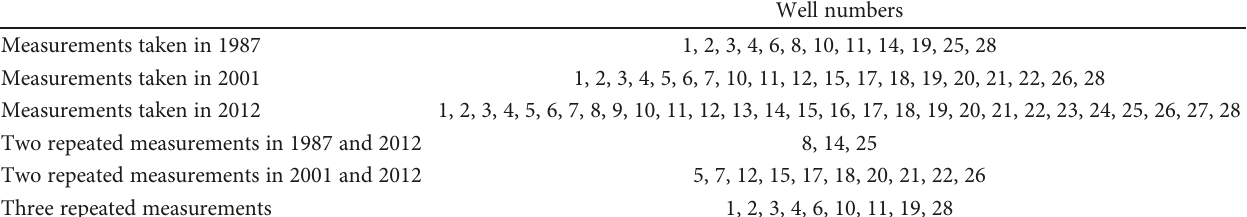
Table 1: Summary of temperature measurements collected in boreholes in di ff erent years.